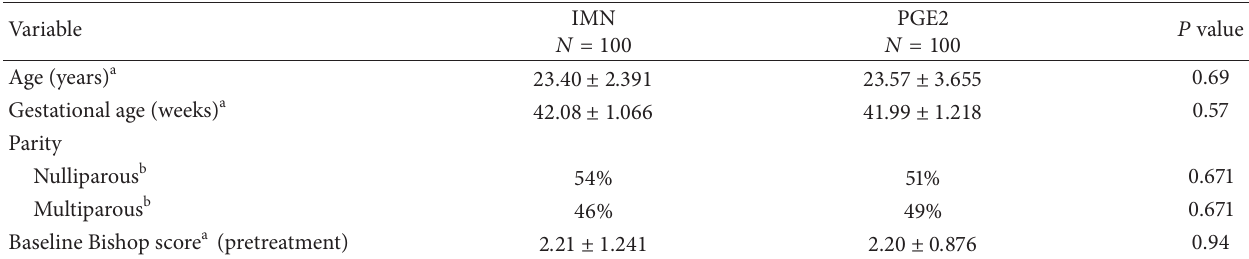
Table 1: Maternal characteristics.